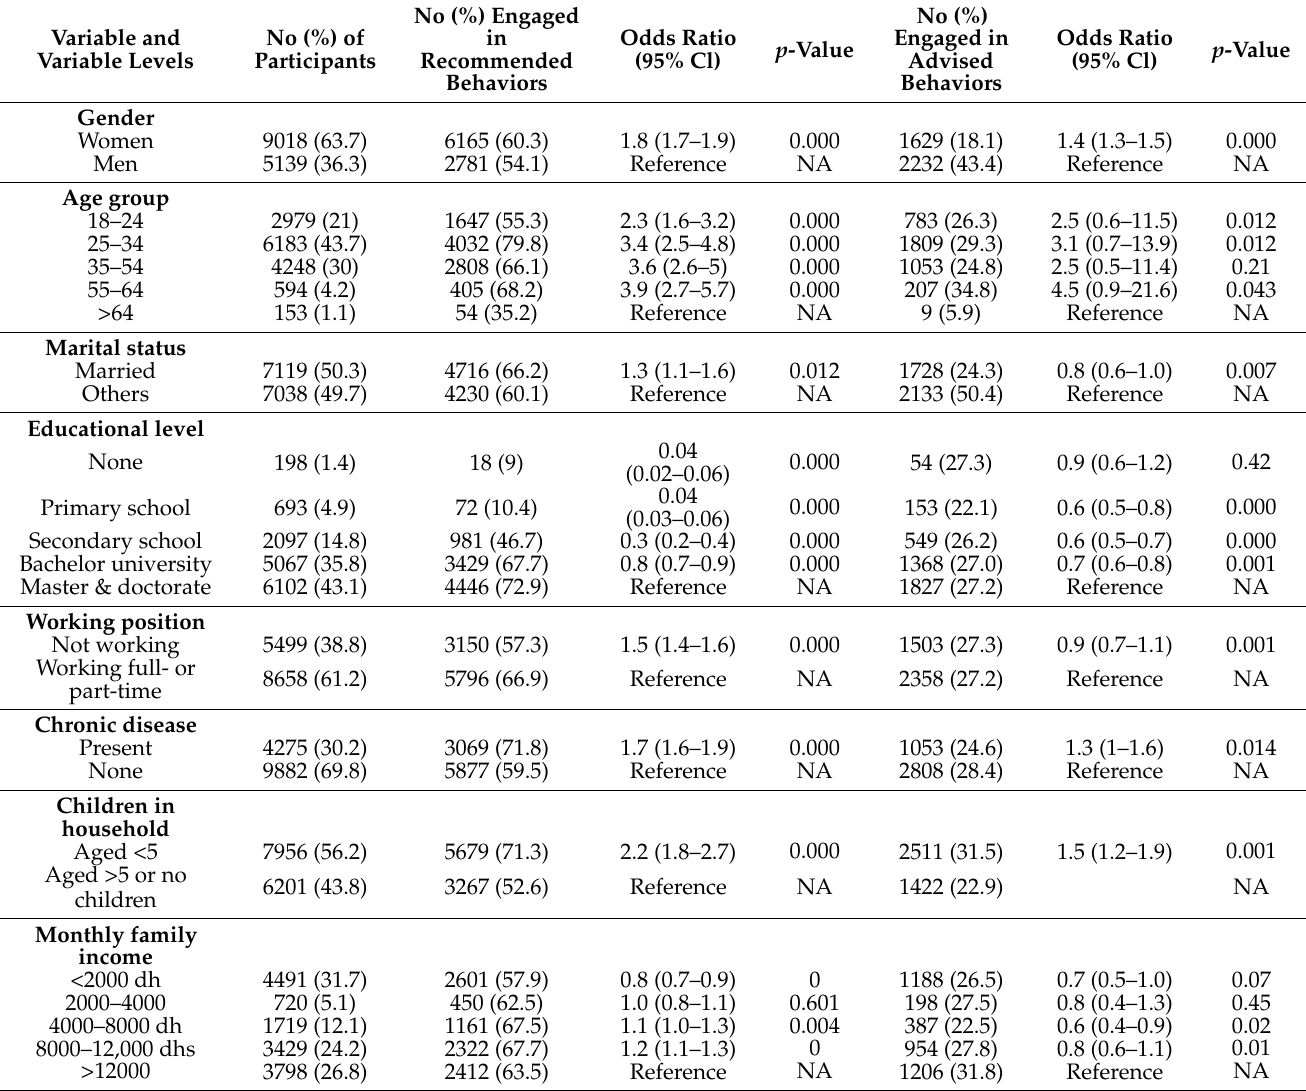
Table 3. Association between personal variables and safety behavior during COVID-19 identified by binary logistic regression